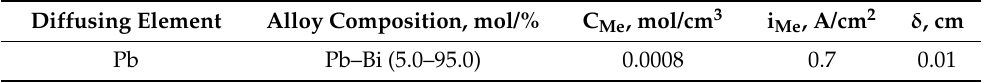
Table 3. The thickness of the diffusion layer in liquid alloys at 823